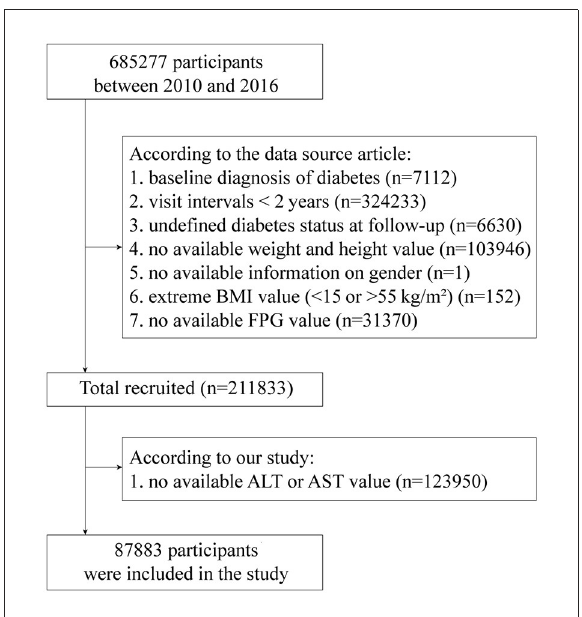
FIGURE1 The flow chart of study participant selection. ALT, alanine aminotransferase; AST, aspartate transaminase; BMI, body mass index; FPG, fasting plasma